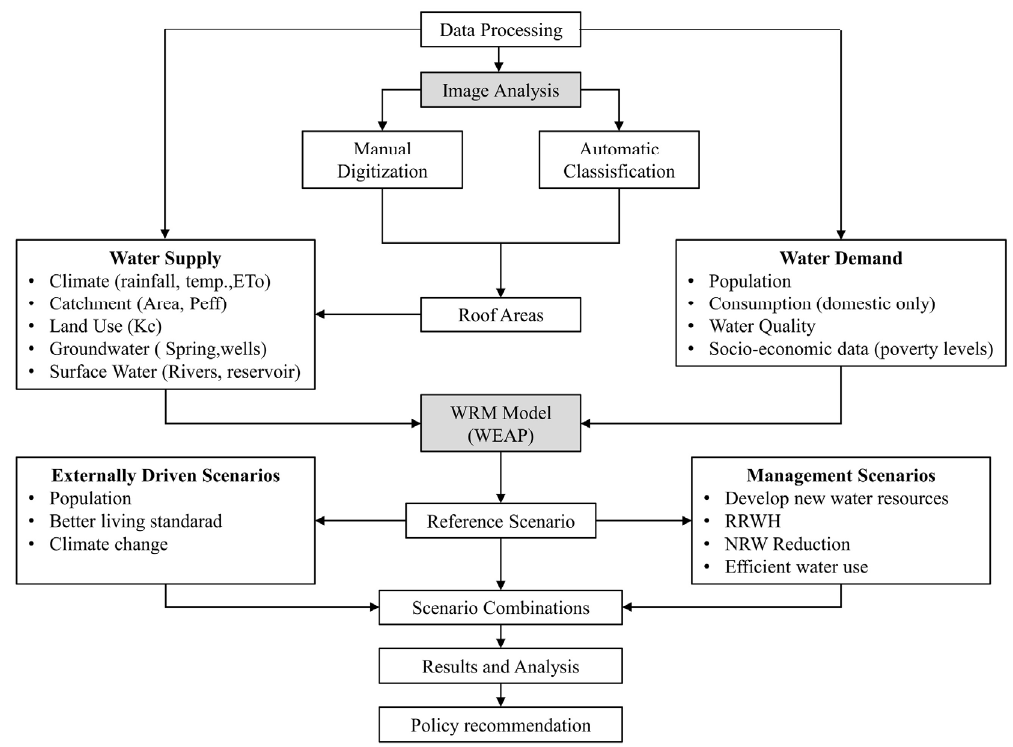
Figure 3. Methodological framework and workflow.